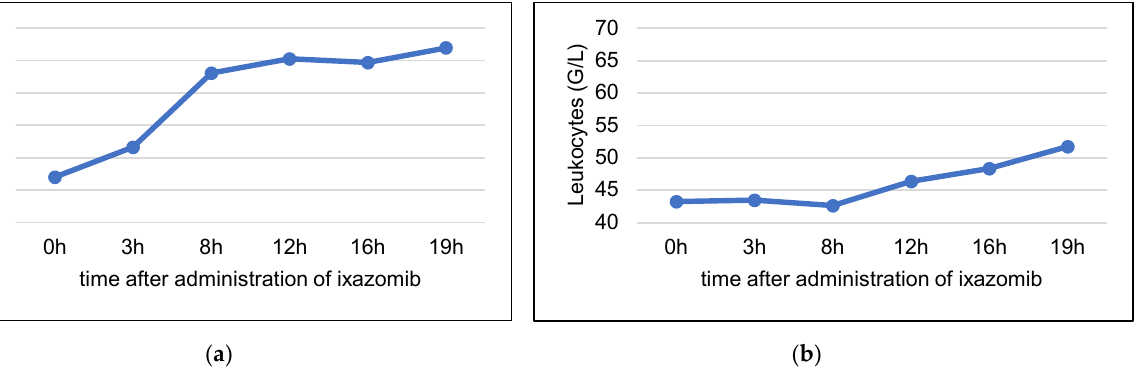
Figure 3. Serial assessment of ( a ) peripheral CD34+ cells and ( b ) leukocytes following administration of ixazomib (single-dose) and GCSF.